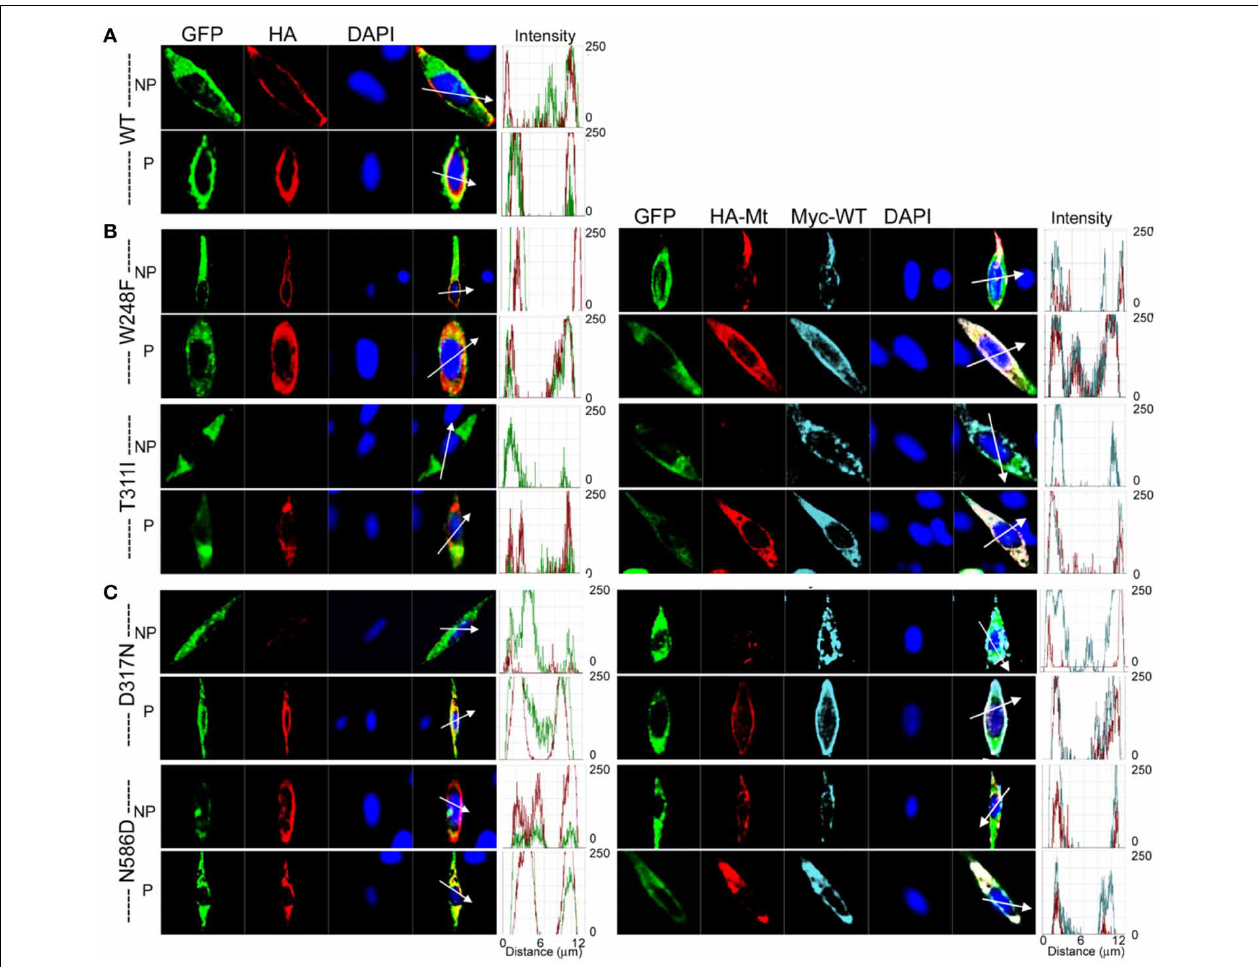
FIGURE 9 | Detection of cell surface expression using epitope tagged hKv7.11. HA- or c-Myc-epitope tag was inserted with an extension of ClC-5 chloride channel D1–D2 loop sequences into the extracellular loop between S1 and S2-transmembrane domains. Farnesylated GFP was used as a plasma membrane binding protein. (A) Wild-type (WT); Anti-HA antibody stained wild-type hKv7.1 protein expressed on the cell surface in non-permeabilized condition (NP), and stained both the cell surface and the cytoplasm expressed proteins in permeabilized condition (P). (B) JLNS mutants (MT); One MT out of 8, W248F, was detected on the cell surface, while T311I was not detected on the cell surface (left panel). When the MT subunit was co-transfected with